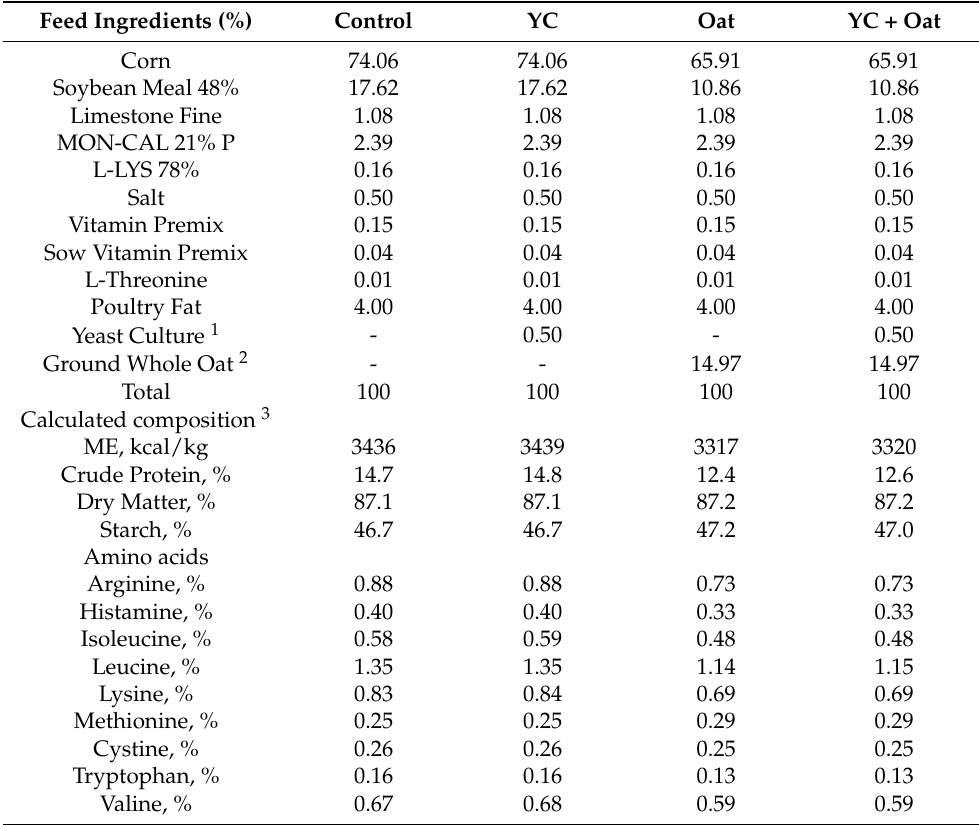
Table 2. Ingredients composition of sow lactation diets.